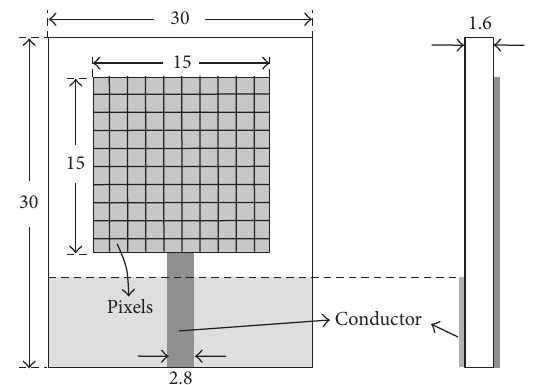
Figure 6: Geometry of the UWB monopole antenna and the discretization of the design space (unit: mm).